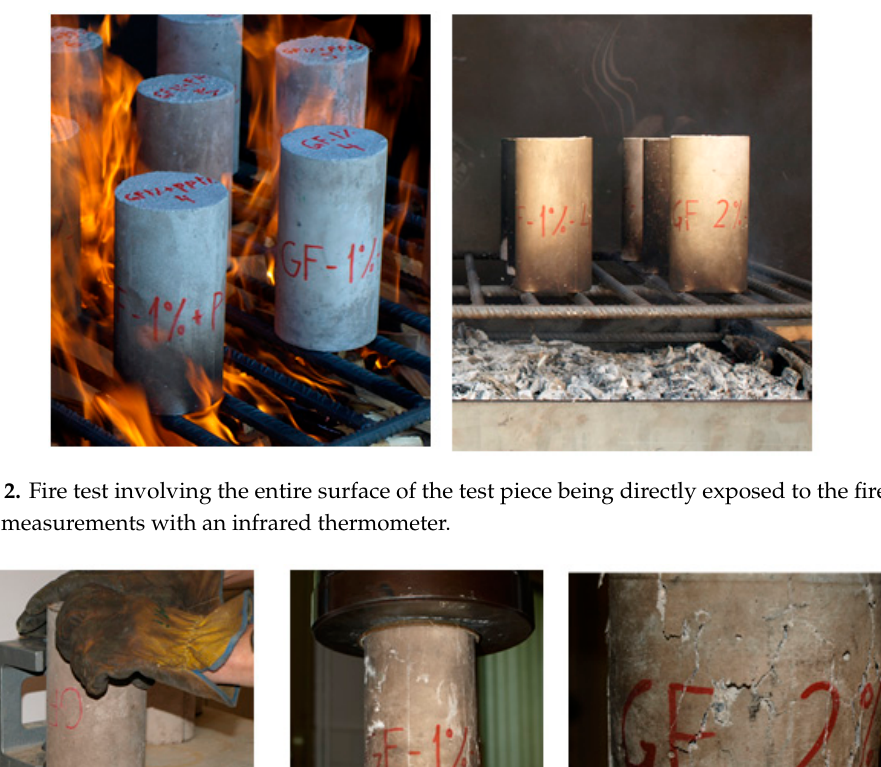
Figure 2. Fire test involving the entire surface of the test piece being directly exposed to the fire and taking measurements with an infrared thermometer.